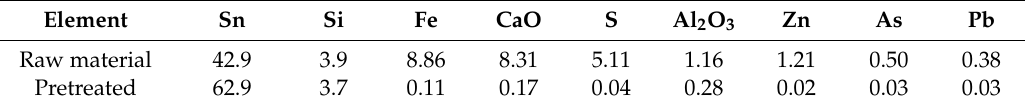
Table 1. Chemical compositions of the original and retreated cassiterite concentrates (wt. %).